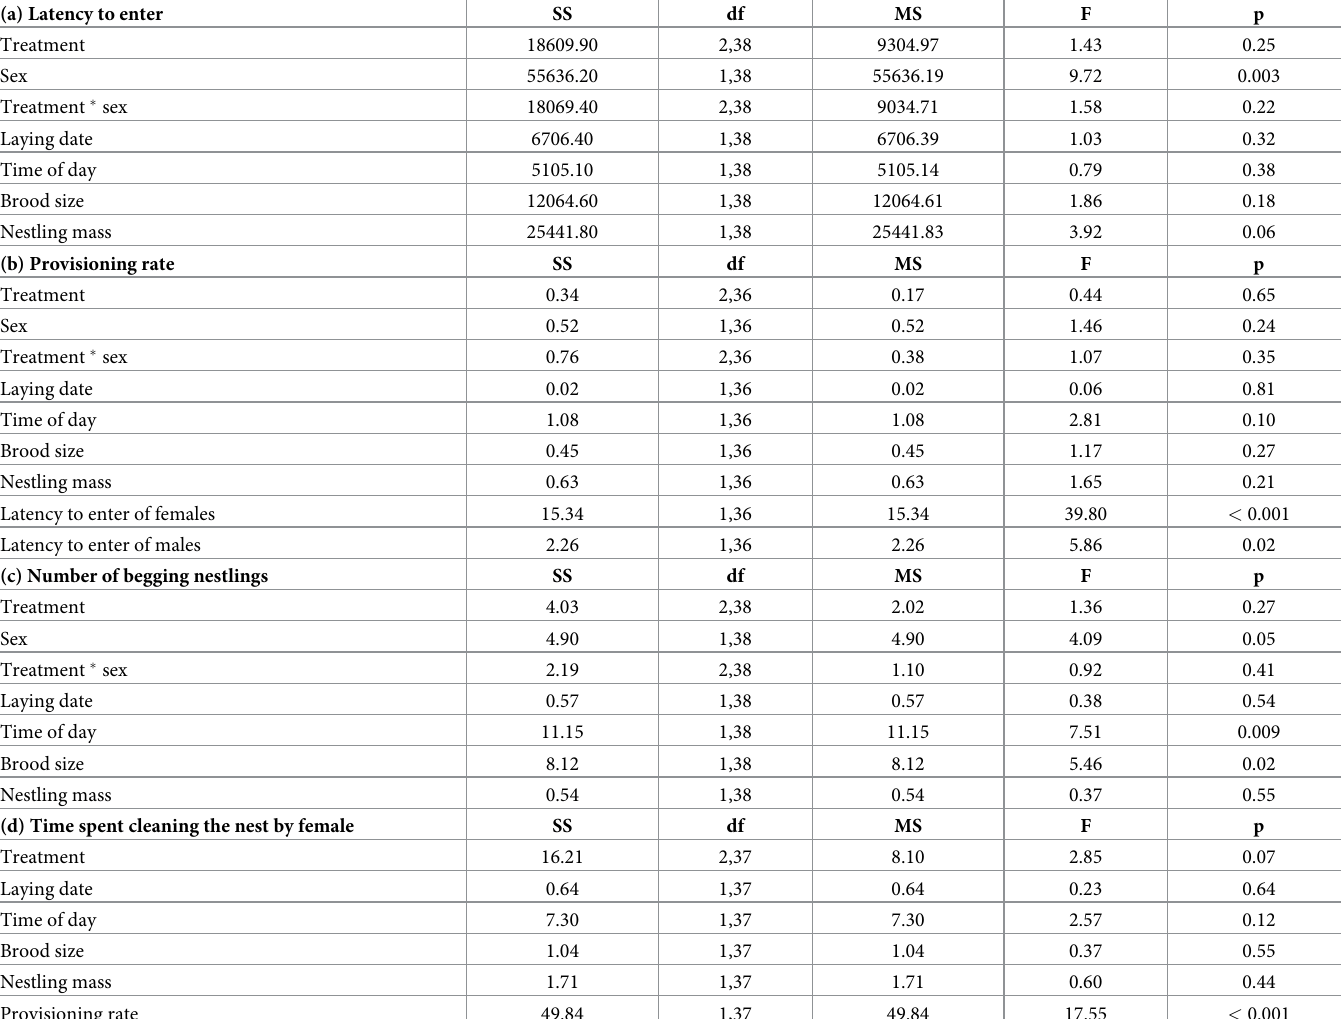
Table 2. Saturated General Linear Models exploring the effects of treatment (control, non-predatory mammal, predatory mammal) and sex (females and males), and their interaction, on behavioral variables of blue tit parents feeding 8-day-old nestlings. Laying date, time of day, brood size and mean nestling mass were included as fixed covariables in all